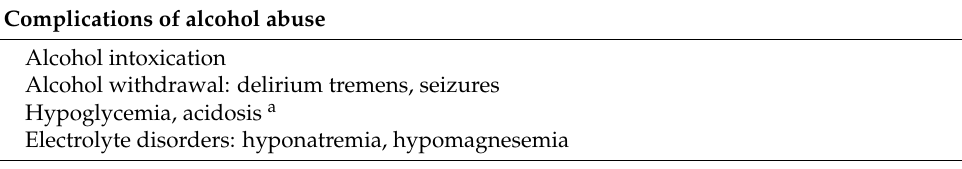
Table 1. Differential diagnosis of confusion, agitation, or drowsiness in patients with alcohol use disorder admitted to our center because of suspected Wernicke-Korsakoff